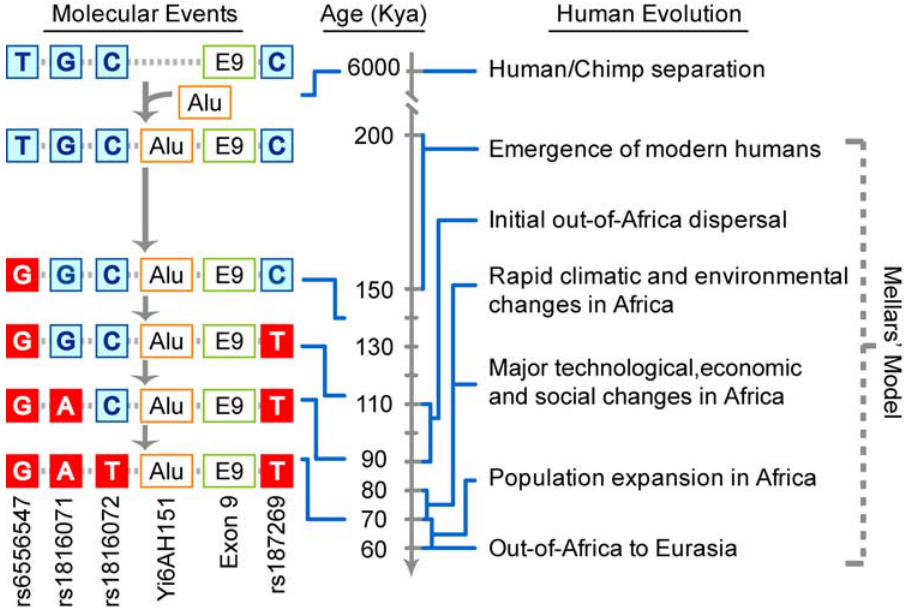
Figure 4. Proposed molecular evolution events in relation to time frame of modern human origins and dispersal from Africa. The age estimates of the four high-D SNPs are shown on the left of this figure. Relevant human evolution milestones, including divergence from chimpanzee and modern human evolution events delineated in Mellars’ model [29], are represented on the right. Yi6AH151 is represented as Alu.